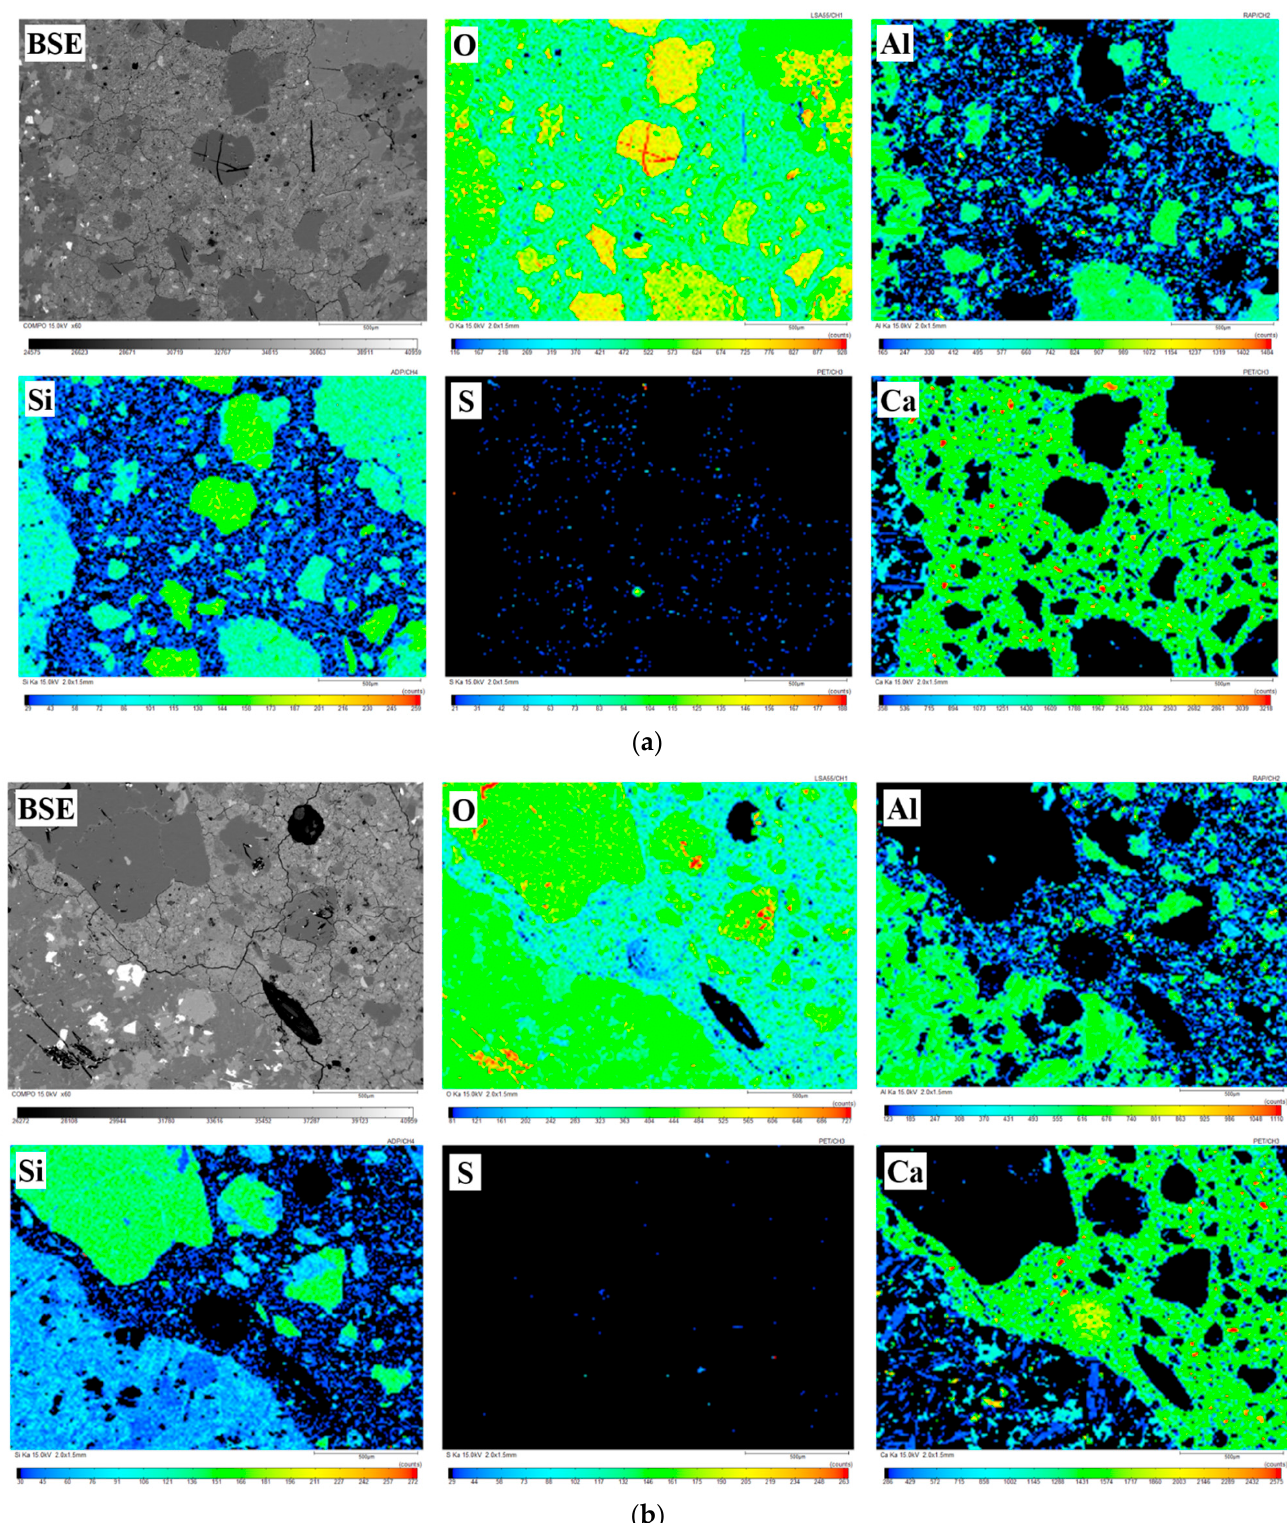
Figure 6. BSE image associated with O, Al, Si, S, and Ca mappings of the PF-NS3 and PF-NS5 sample after abrasion. ( a ) PF-NS3 sample, ( b ) PF-NS5 sample.